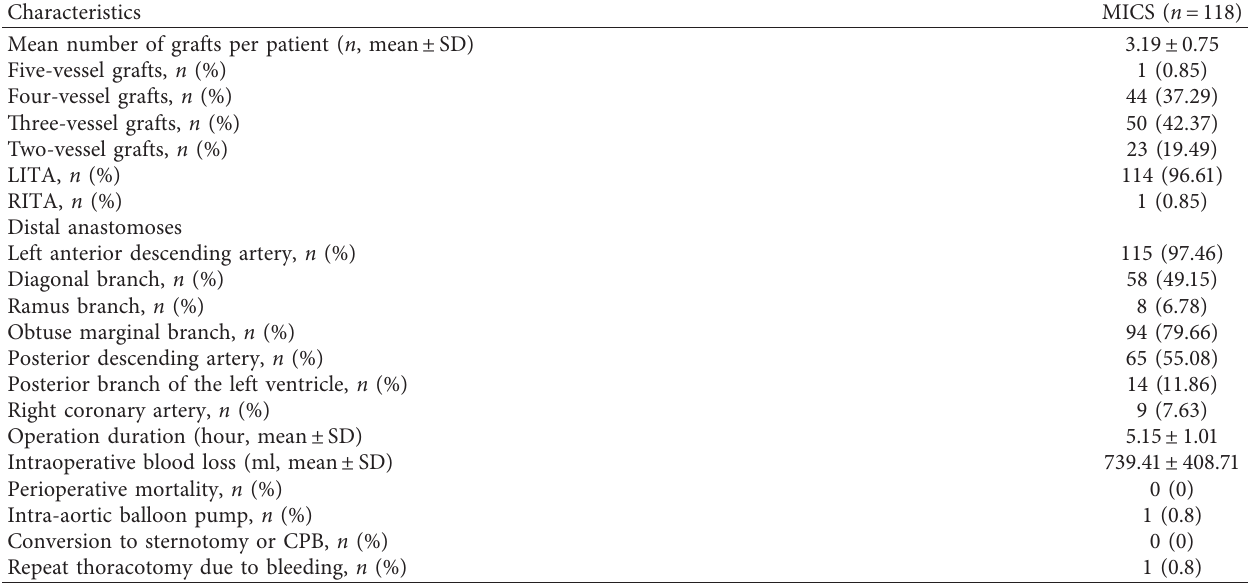
Table 2: Procedural characteristics and postoperative outcomes ( n �